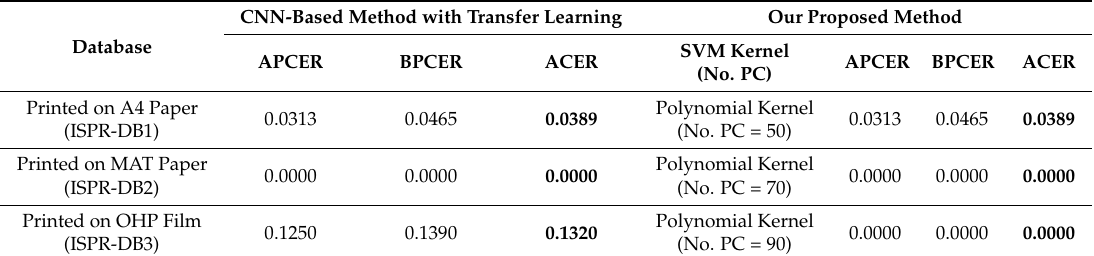
Table 16. Detection errors of our proposed method using VGG-16 network architecture in Table 4 on sub-databases of ISPR-DB based on the printing materials (unit: %).